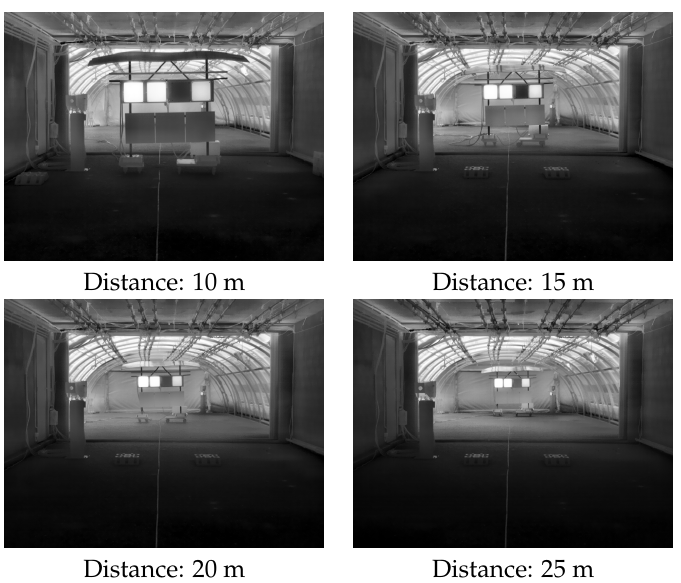
Figure 8. Examples of different MORs.